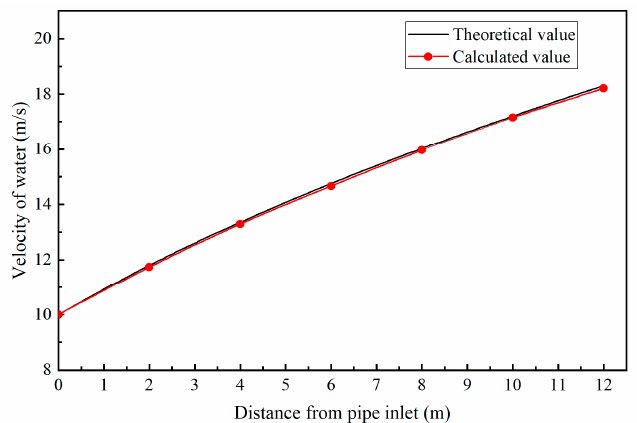
Figure 2. Distribution of liquid phase volume fraction at different moments: ( a )–( a’ ) Initial; ( b )–( b’ ) Transient state; ( c )–( c’ ) Stable.